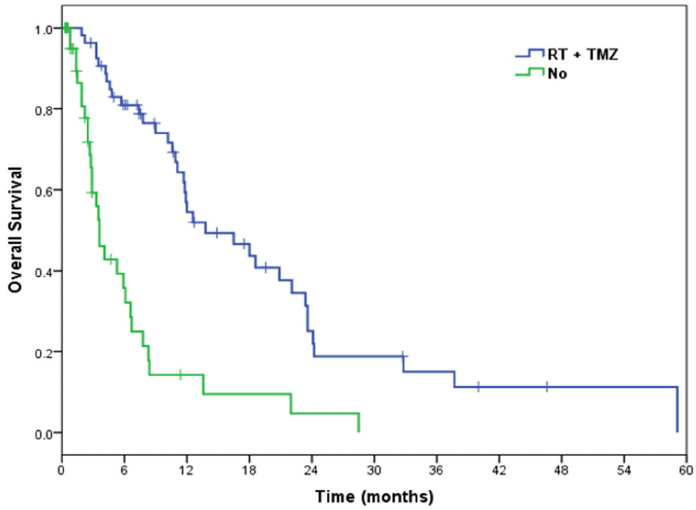
Figure 3. OS Kaplan-Meier curves for the RT + TMZ: yes (median OS = 13.8 months) vs. no (median OS = 3.6 months). The multivariate OS analysis with Cox regression showed that the RT + TMZ (no vs.